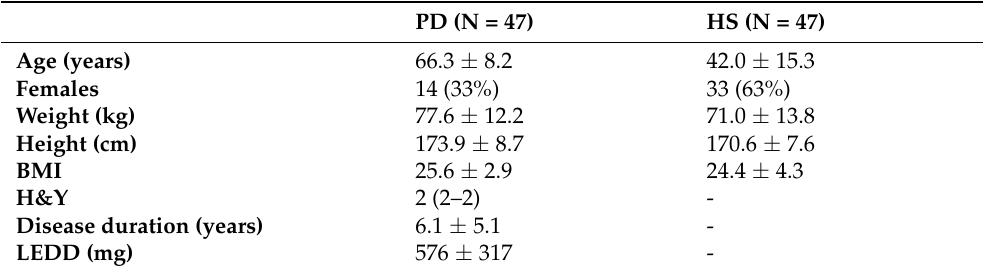
Table 1. Demographic and clinical features of the enrolled population. BMI: body mass index; H&Y: Hohen and Yahr disease stage; HS: healthy subjects; LEDD: Levodopa equivalent daily dose; PD: Parkinson’s